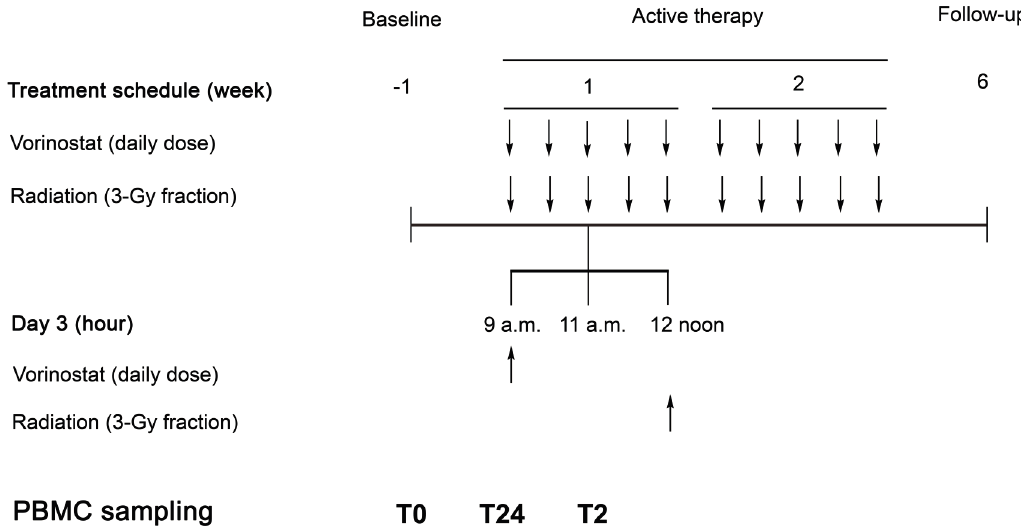
Figure 3. Pelvic Radiation and Vorinostat: design of the vorinostat biomarker study. Arrows indicate administration of therapy (daily vorinostat dose at 9 a.m. and daily exposure to a 3-Gy radiation dose at 12 noon) for ten days. Peripheral blood mononuclear cells (PBMC) were sampled at baseline, before commencement of treatment (T0), and on active therapy, two hours (T2; at 11 a.m. on day 3) and 24 h (T24; at 9 a.m. on day 3) after the previous dose of vorinostat. Treatment toxicity, assessed as detailed in Section 3, was recorded continuously during treatment and re-examined six weeks after treatment completion (at follow-up). The figure has been published previously by Ree and co-workers and is reproduced with permission